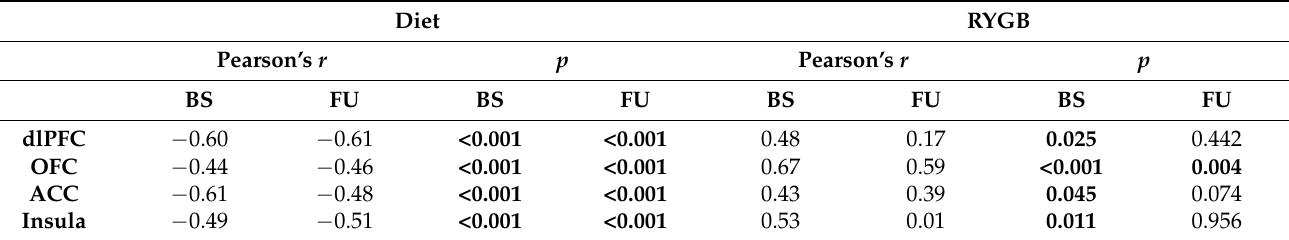
Table 5. Correlations and p -values between BAS reward responsiveness and 5-HTT BP ND (before intervention, baseline, BS; after 6 months of intervention, follow-up,